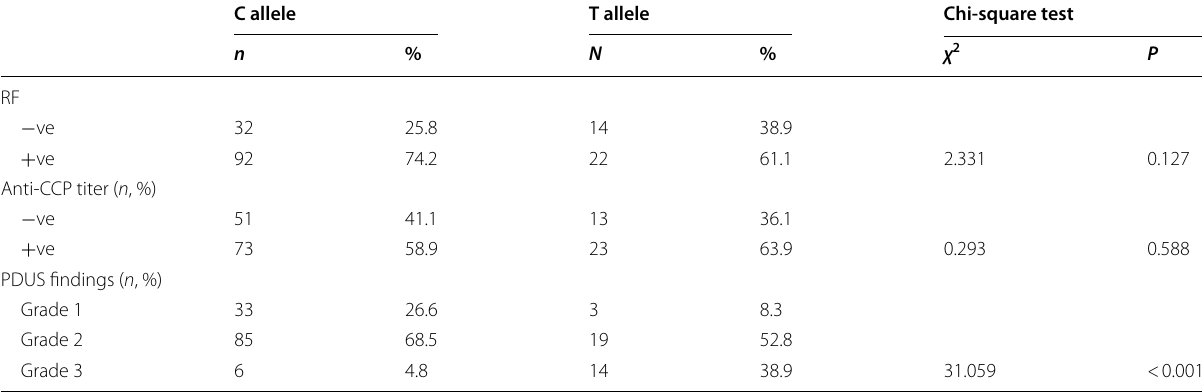
Level of significance at P